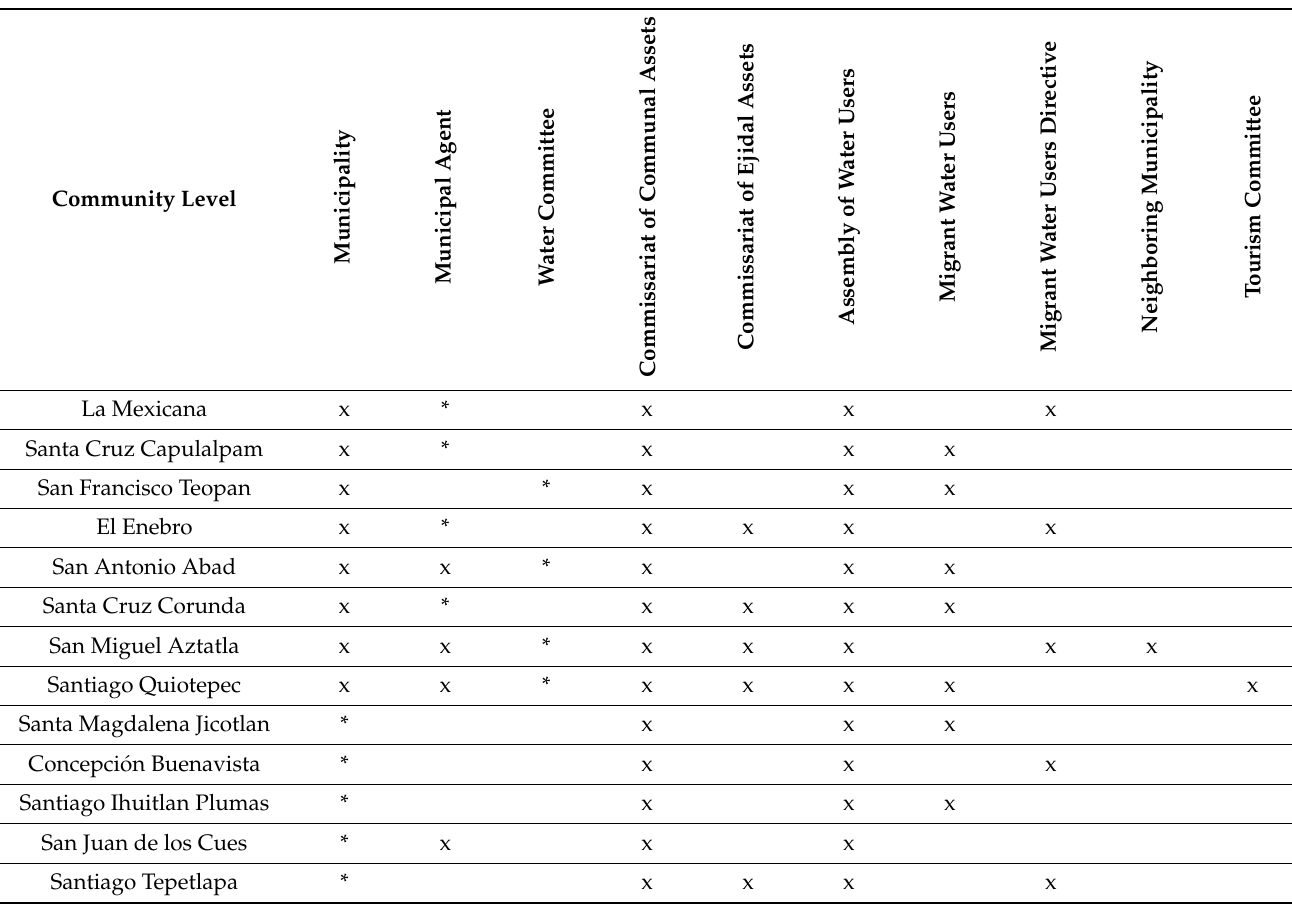
Table 3. Interactions between actors at the local level within the 13 studied communities. The commissariat of communal or ejidal assets corresponds to those responsible for the ejido agrarian territory or agrarian community with collective land tenure. * Stakeholder responsible for the operation of the water supply system for domestic use in the community.